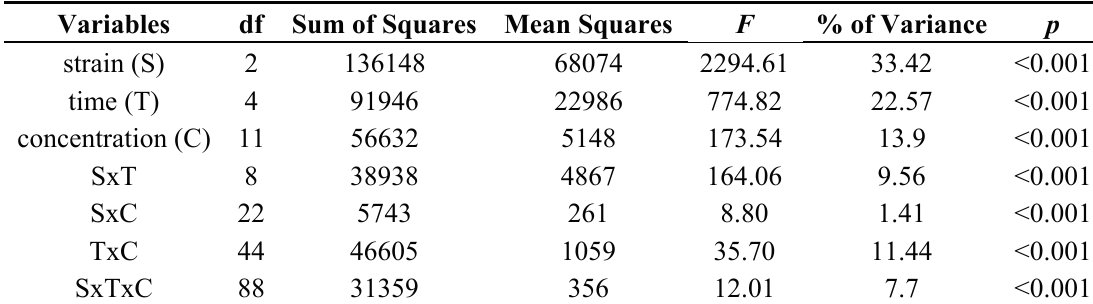
Table 3. Multivariate analysis of variance by three-way ANOVA of proliferation kinetics of oral streptococci strains exposed of BECl expressed as reduction of AlamarBlue. The comparisons and interactions between “strain”, “time” and “concentration” factors were statistically significant ( p <